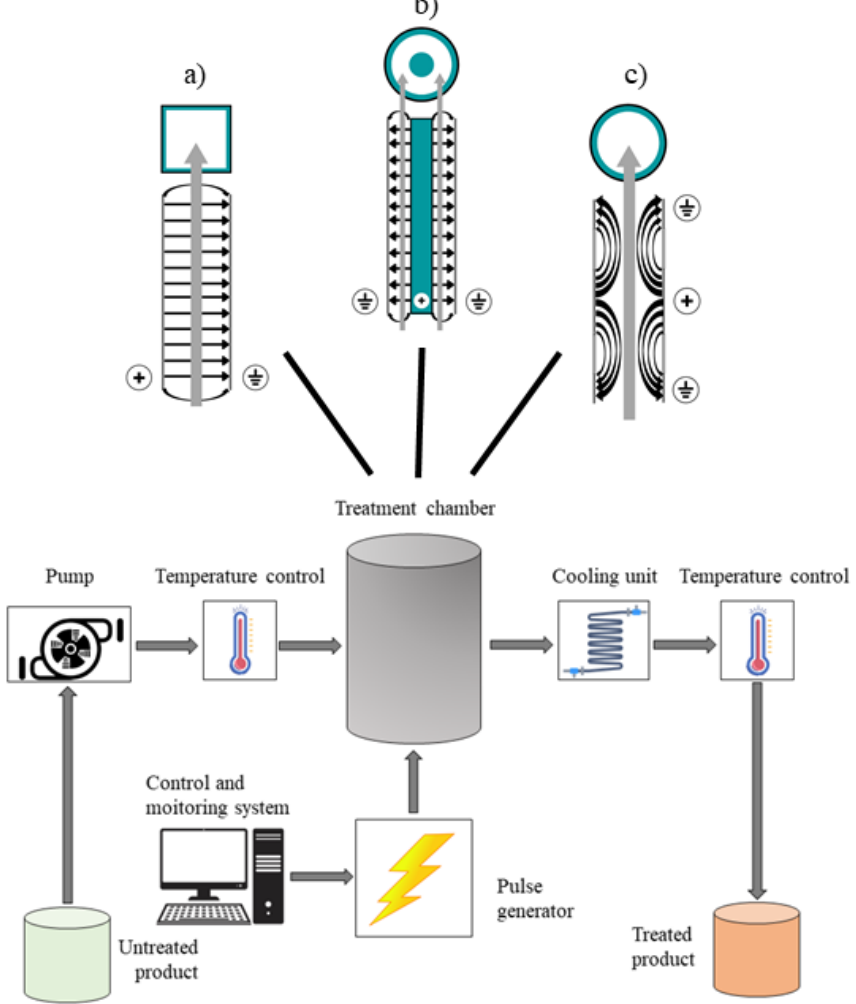
Figure 5. Schematics of a typical continuous flow PEF system, and cross-sectional views of different treatment chamber configurations; ( a ) parallel plate, ( b ) co-axial, ( c ) collinear, (the grey arrows are representative of the product flow).